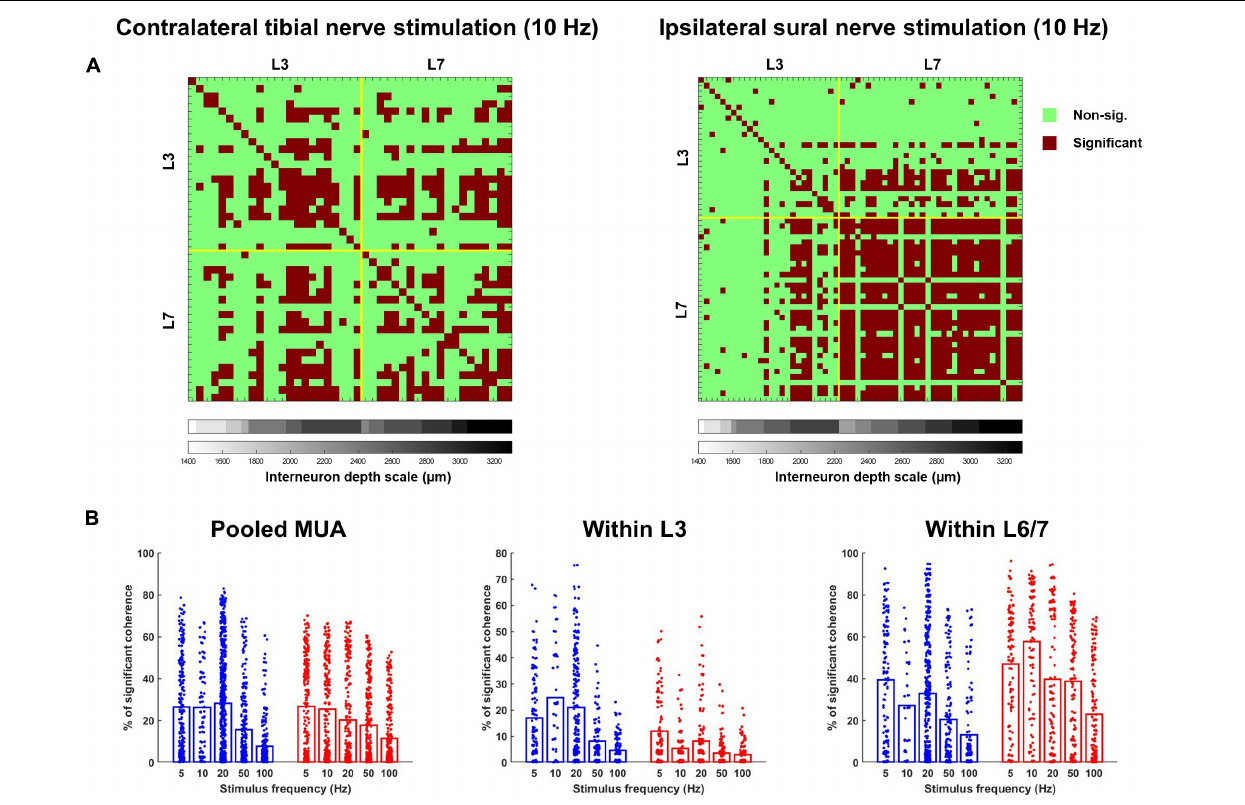
FIGURE 9 | (A) Matrices illustrating the incidence of significant coherence between interneurons during exemplar trials of 10 Hz tibial (left) and sural (right) nerve stimulation. Yellow lines separate units recorded at the rostral (L3) and caudal (L6/7) recording sites. Within each recording site, interneurons are stratified by depth, with deeper units plotted further to the right. (B) Percentage of interneuron population significantly cohered to discharge of individual interneurons across frequencies in response to contralateral tibial [blue; (A) ] and ipsilateral sural [red; (B) ] nerve stimulation. Bars represent means; data points are jittered with uniformly distributed noise to minimize overlap.